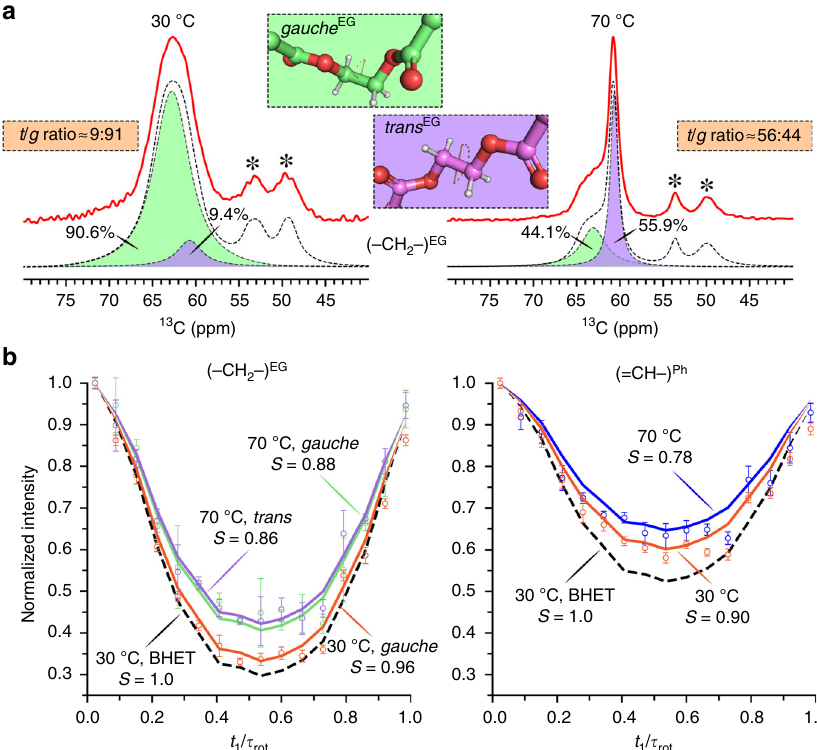
Fig. 1 MAS NMR of amorphous PET powder at 30 °C and 70 °C. a 13 C spectra in the range of 40 – 80 ppm showing the characteristic spectra for the EG carbons. The trans and gauche contents were quanti fi ed by fi tting a Voigt function to the experimental spectra (red). The sum of the Voigt fi ts (shaded in purple and green, respectively, for trans and gauche conformers) is shown as dotted curve. The inset shows the EG fragment in the trans and gauche conformations. MAS sidebands are denoted by asterisks. b 1 H – 13 C DIPSHIFT curves for phenylene and EG carbons acquired at a MAS rate of 8 kHz. The solid lines are the best- fi t simulations and dashed lines represent the rigid limit. Experimental error bars were determined from the noise level. Order parameters S from the measured dipolar couplings are